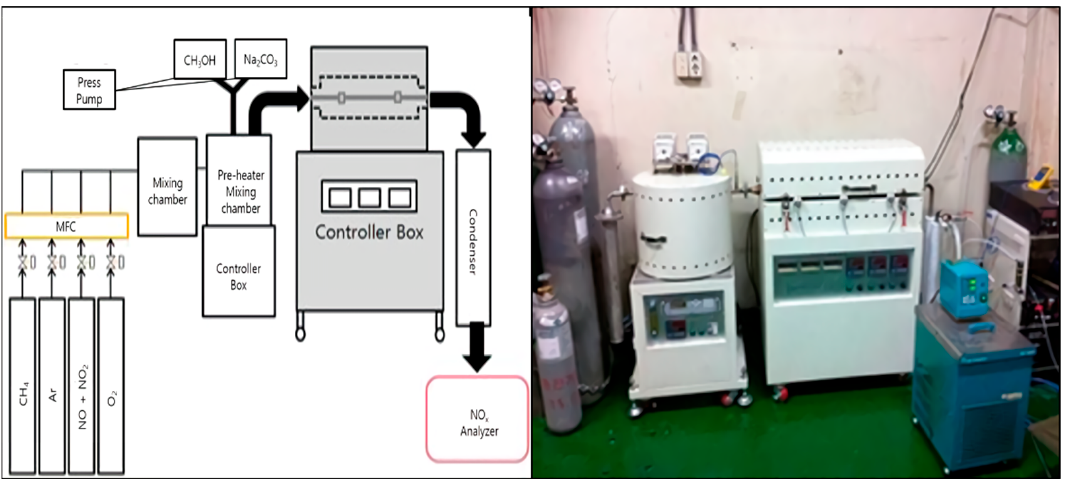
Figure 1. Schematic of the experimental procedure and the lab-scale SNCR process. Among the gases emitted after SNCR, NO x and O 2 were quantified using a portable flue gas analyzer (GreenLineMK2, Il-Sang Co., Ltd., Korea) of the electrochemical